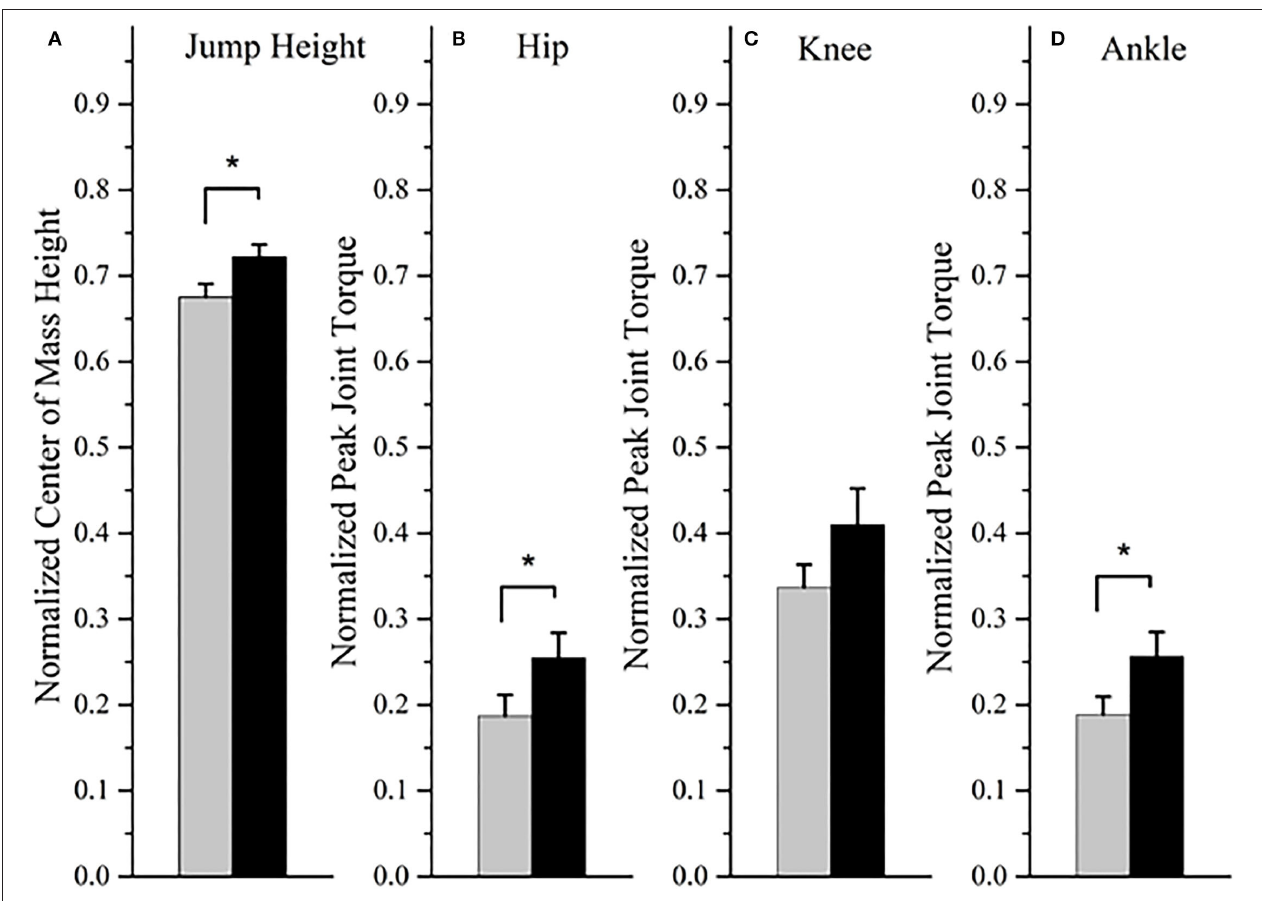
FIGURE 2 | The jump height (A) and peak joint torque of the hip (B), knee (C) , and ankle (D) at baseline (gray bar) and post-training (black bar). Expressed as the mean and standard error. * P < 0.05 for the Wilcoxon signed-rank